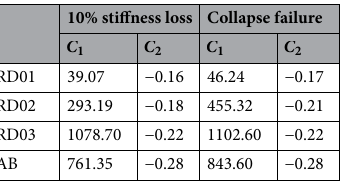
Table 4. Coefficients for Basquin’s exponential S–N curves of FCCm structures.